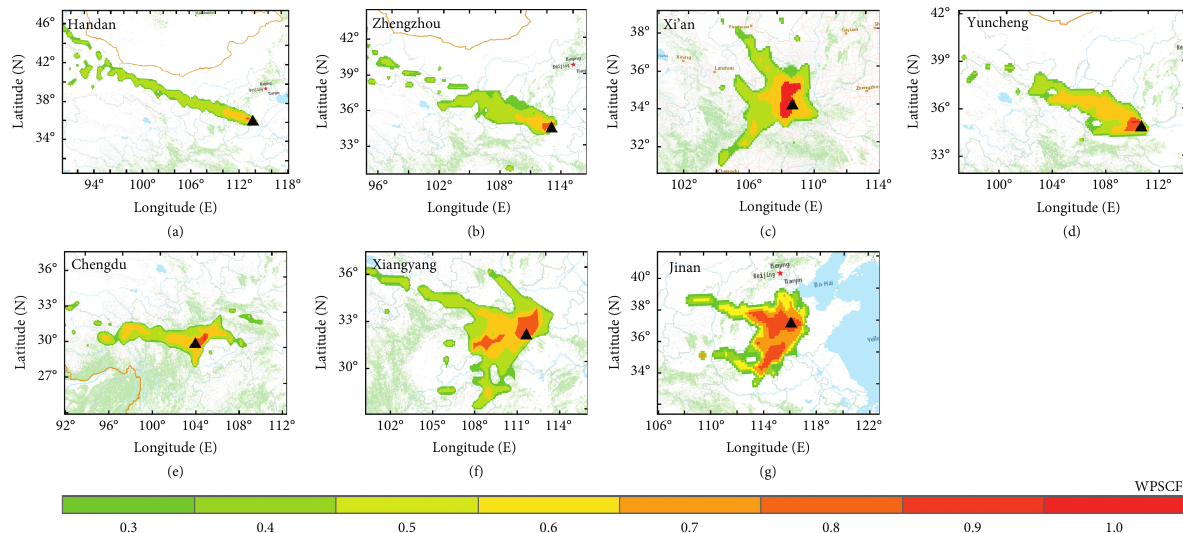
Figure 8: Potential sources of PM 2.5 in seven Chinese cities according to the Weight Potential Source Contribution Function (WPSCF), with the large black triangles representing cities.